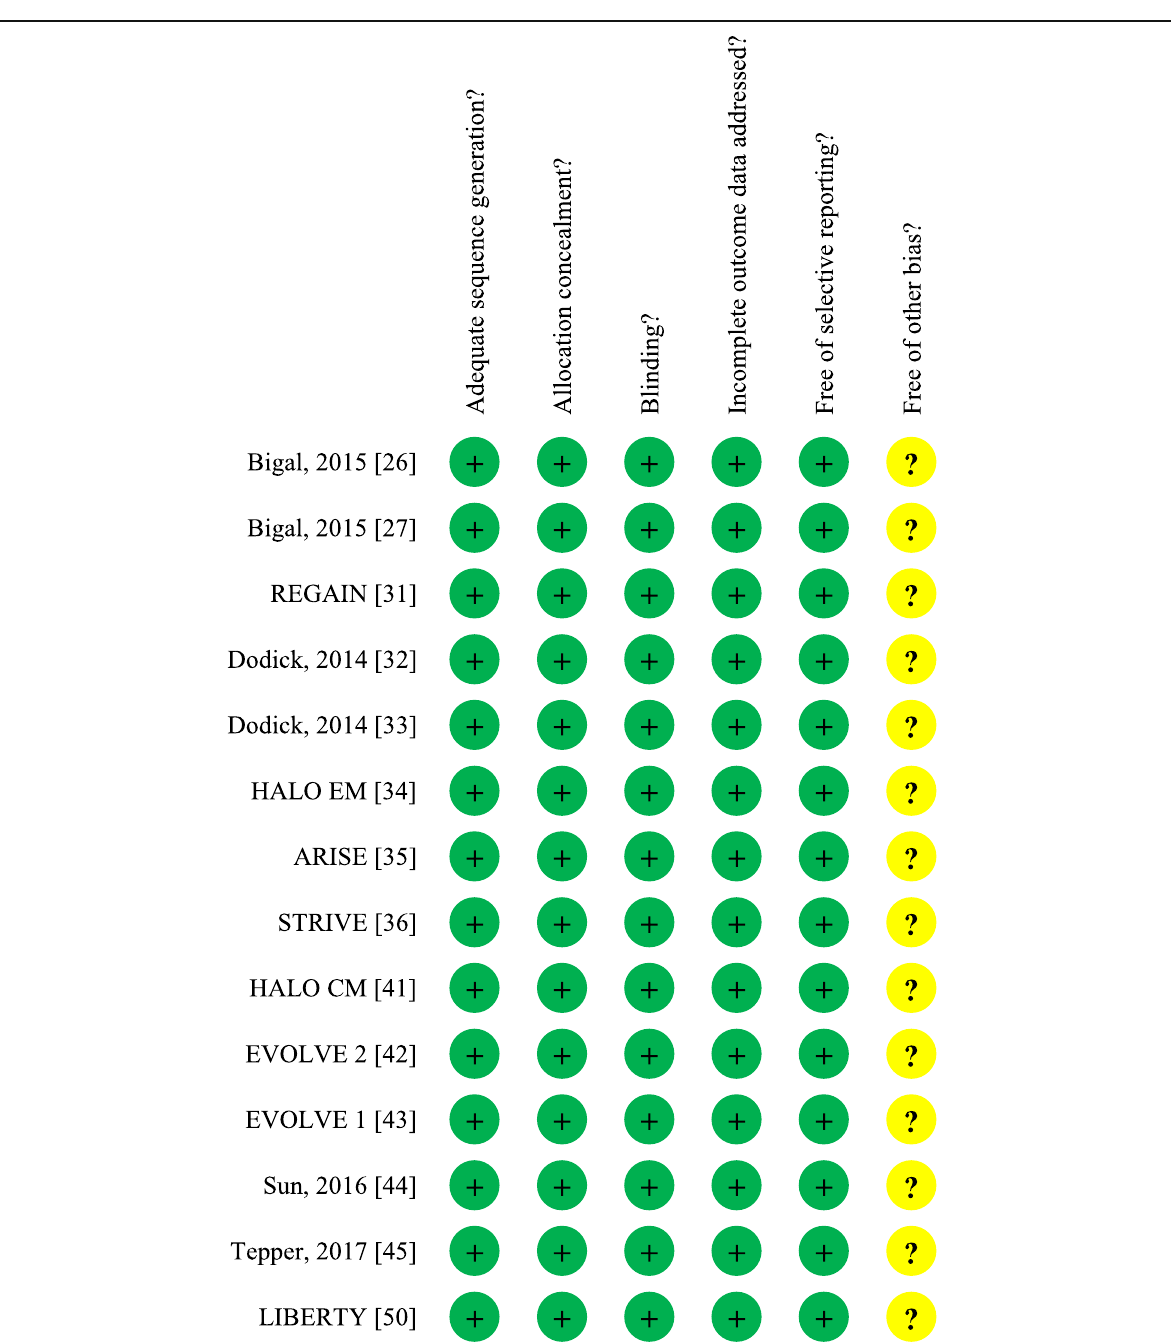
Fig. 2 Risk of bias summary for the studies considered for the